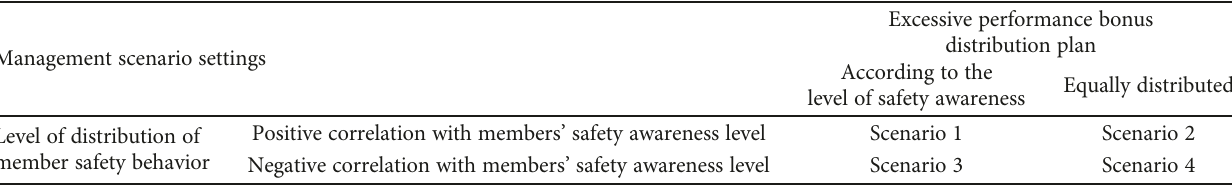
Table 4: Four management scenarios for safety performance